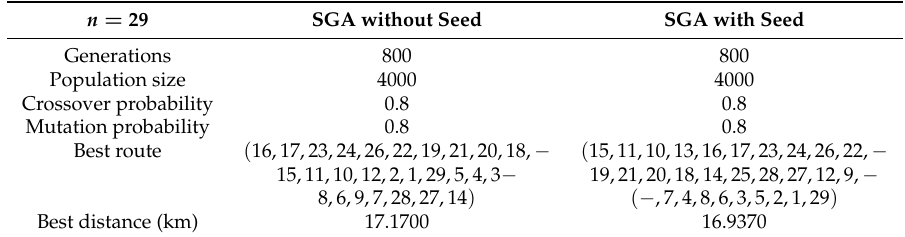
Table 12. Results of the n = 29